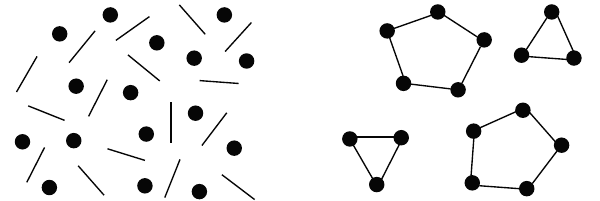
Figure 1. An example of the connectedness illusion. The number of elements connected by lines (right) is typically underestimated compared to unconnected elements